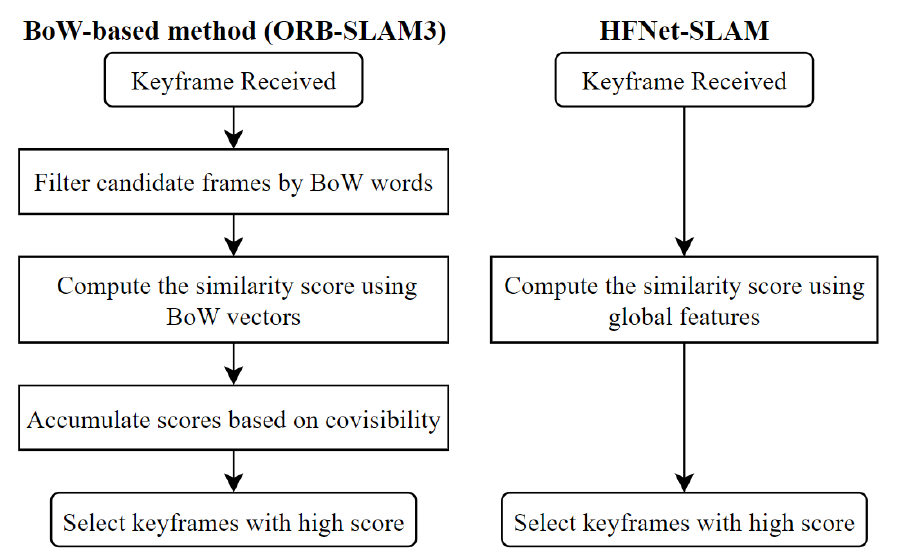
Figure 3. Plot of image retrieval modules in ORB-SLAM3 and